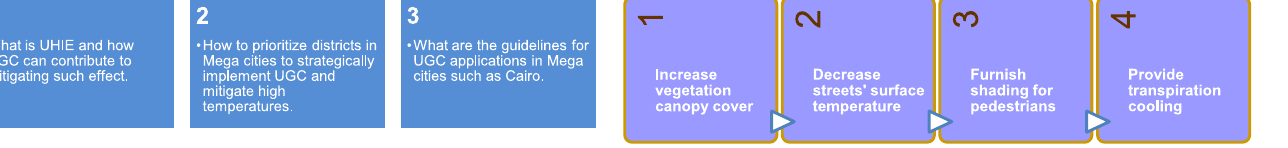
Fig. 2. Goals of good selection of urban green coverage.